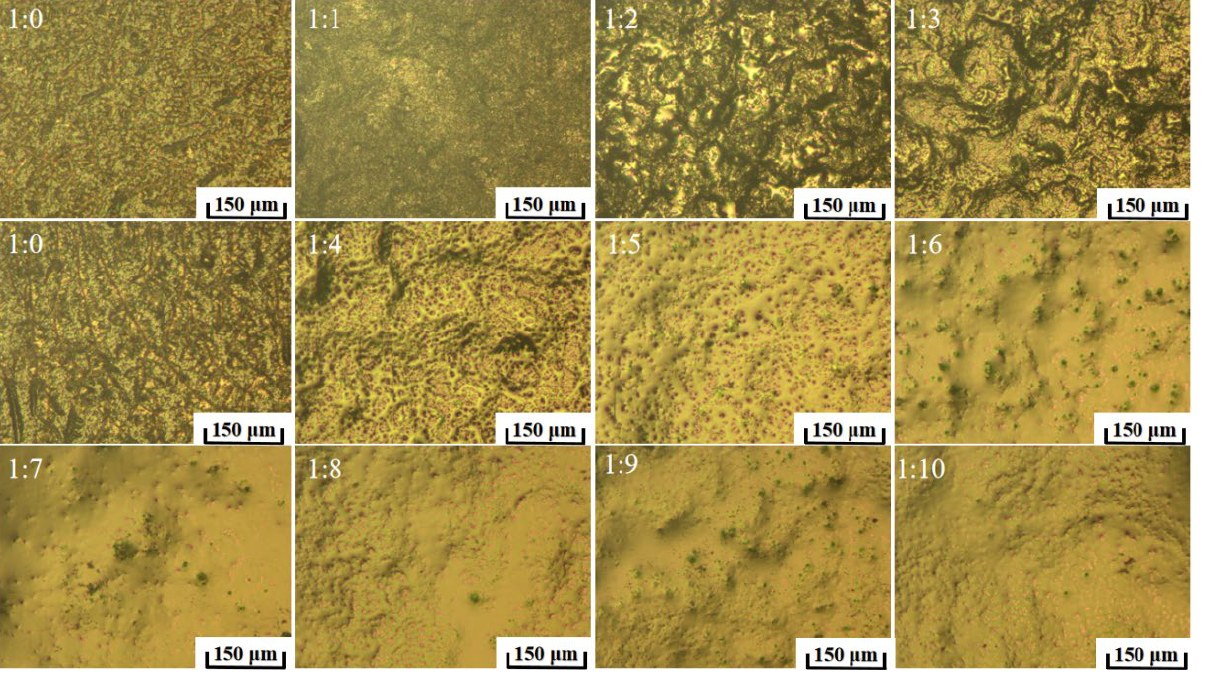
Figure 5. Microscope morphology photos of PEDOT:PSS/epoxy coatings (top light source) with different P:E ratios.